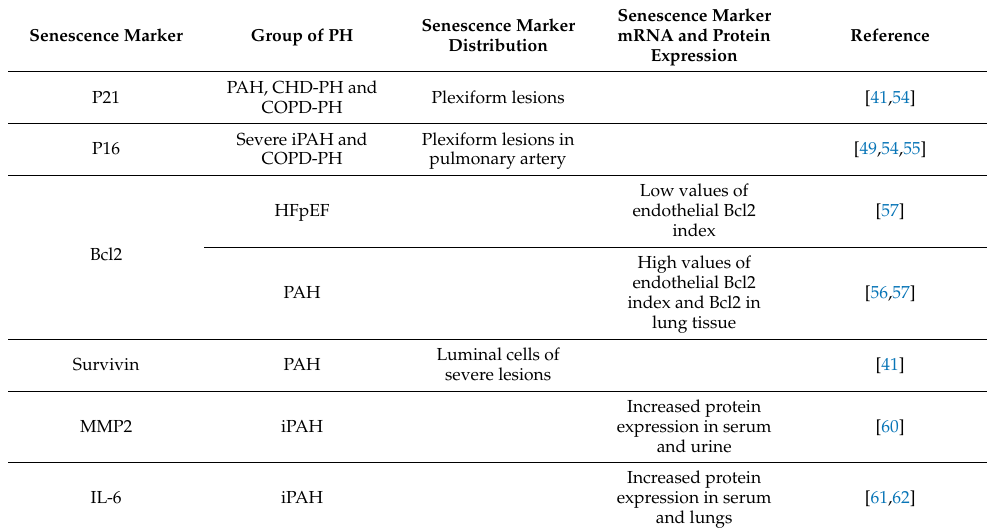
Table 4. Summary of senescence markers’ expression and distribution studies in patients with PH. Senescence